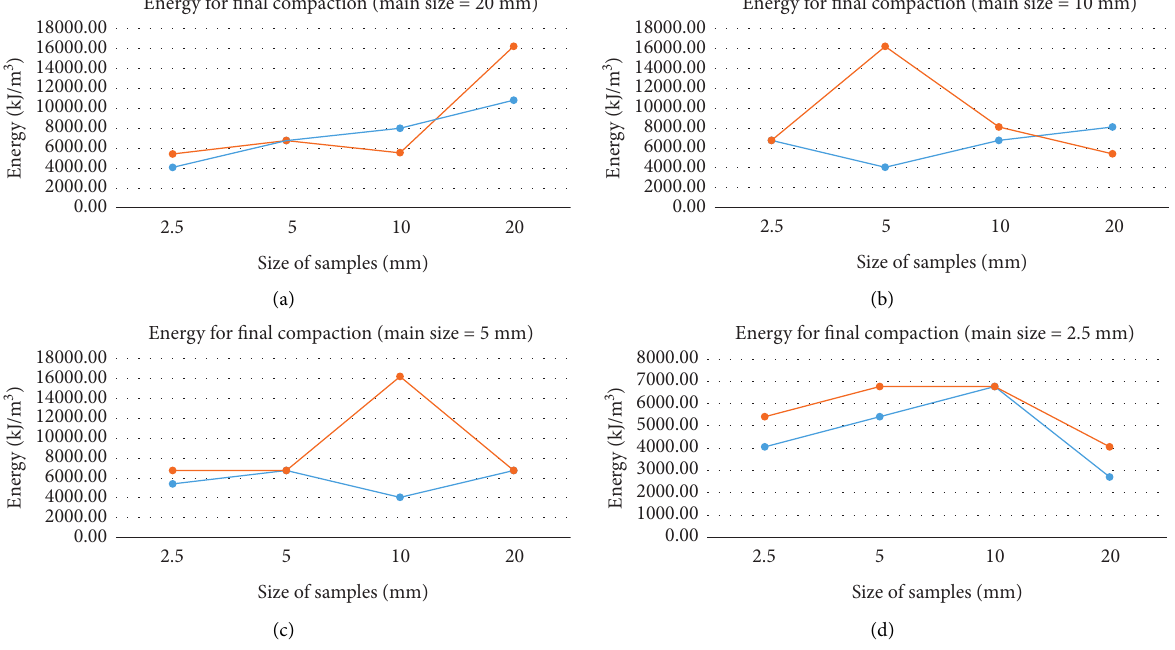
Figure 19: The amount of energy required for mixed materials with a weight ratio equal to 2.5, 5, 10, and